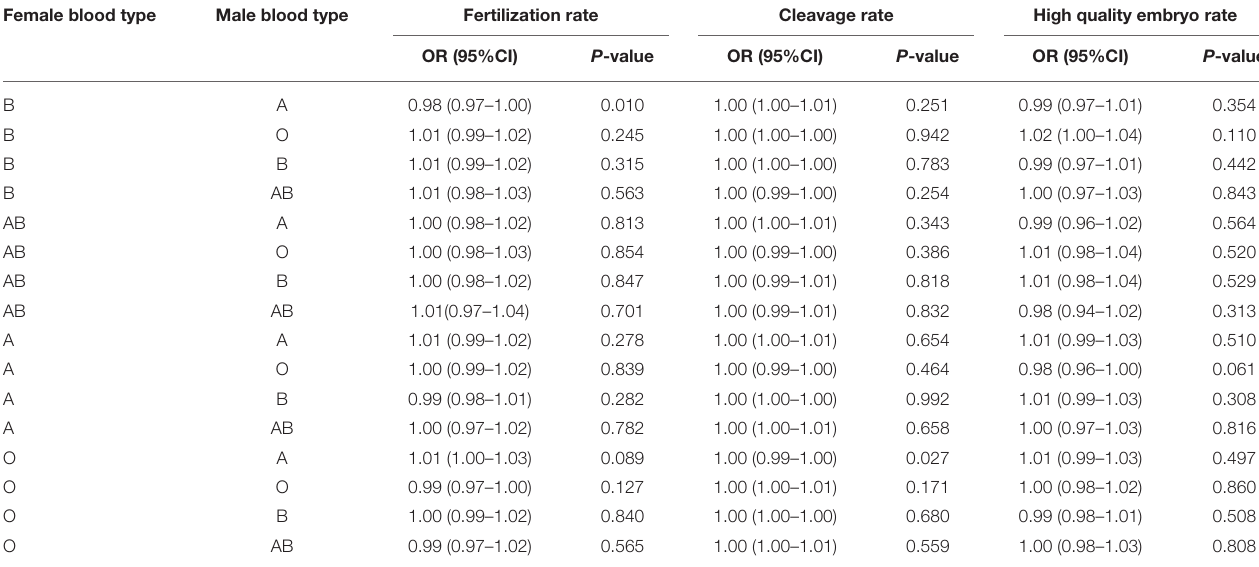
TABLE 3 | Multivariate logistic regression analyses between embryo quality parameters and parental blood type combinations by adjusting for controlled ovarian hyperstimulation protocols. Female blood